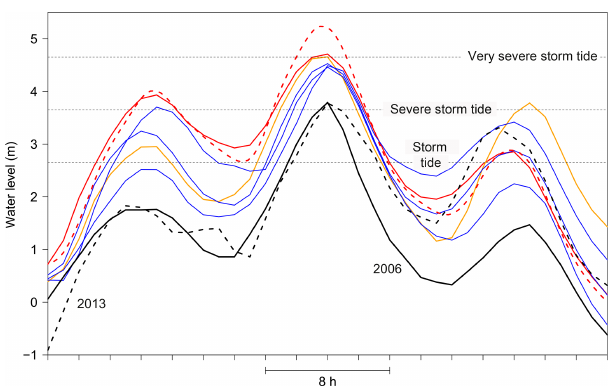
Figure 3. Time series of water levels over 36h for Borkum. The two black curves display observations (data source: German Fed- eral Waterways and Shipping Administration – WSV – communi- cated by the German Federal Institute of Hydrology – BfG), and the coloured curves represent the five highest simulated storm tides (nearest seaward grid point to Borkum) from the data set. The red and the orange curves denote the two highest events (EH and EL) used for amplification tests; the dashed red curve displays the am- plified event EH_a (see Sect.